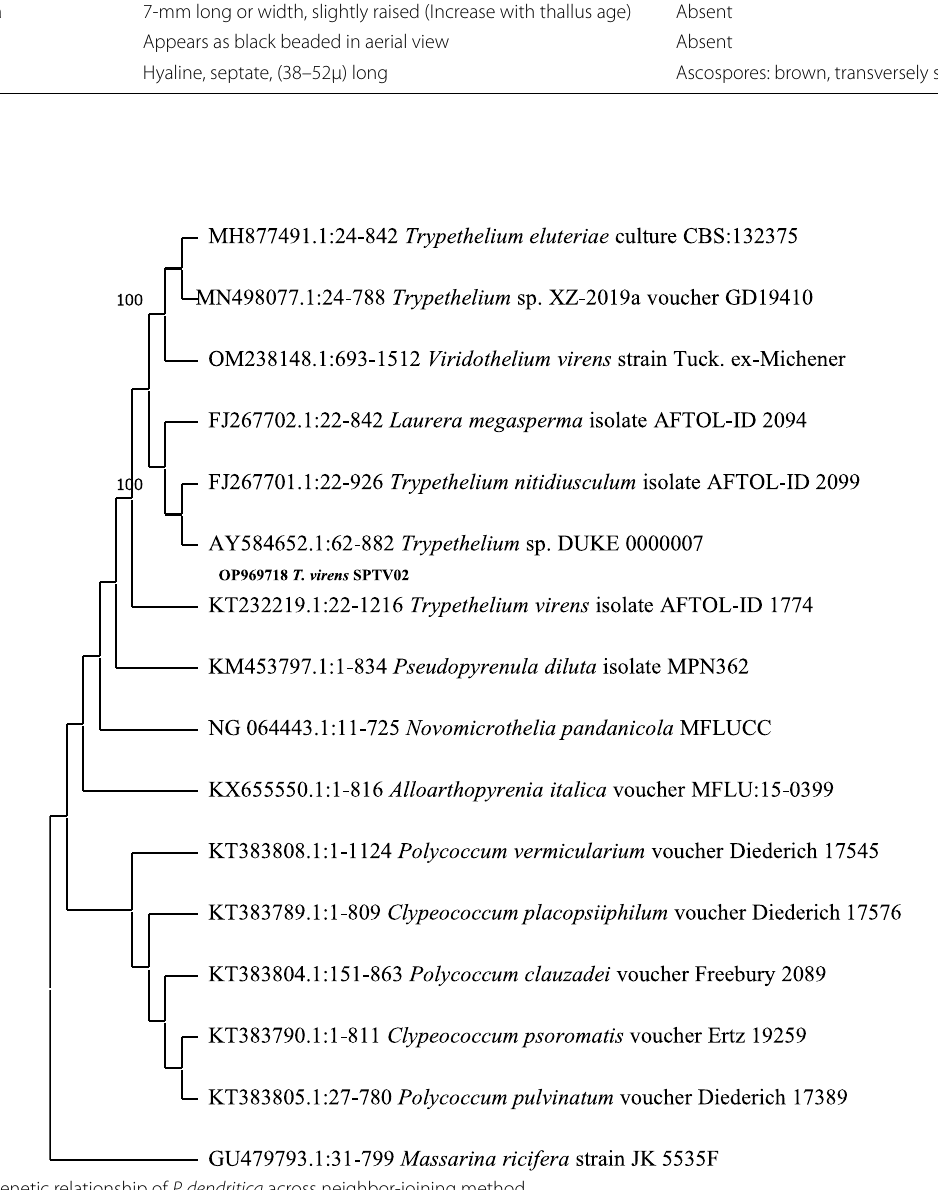
Fig. 4 Phylogenetic relationship of P. dendritica across neighbor‑joining